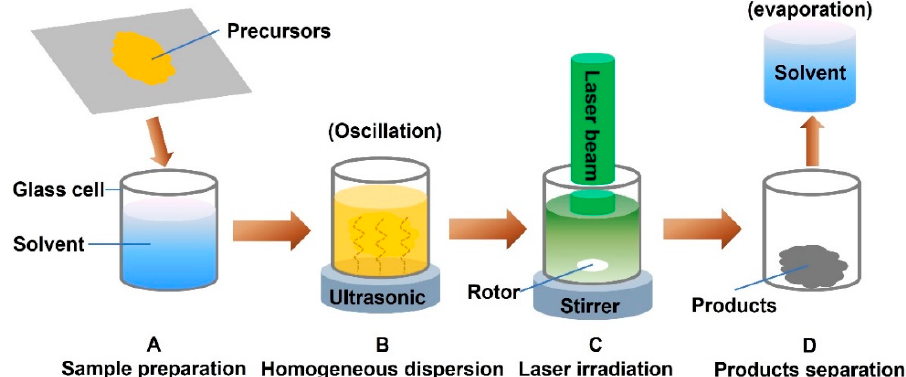
Figure 4. A schematic diagram of the whole procedure for pulsed laser synthesis of the nanocomposite. ( A ) Sample preparation. ( B ) Homogeneous dispersion. ( C ) Pulsed laser irradiation. ( D ) Products separation. Reprinted with permission from Ref. [43].